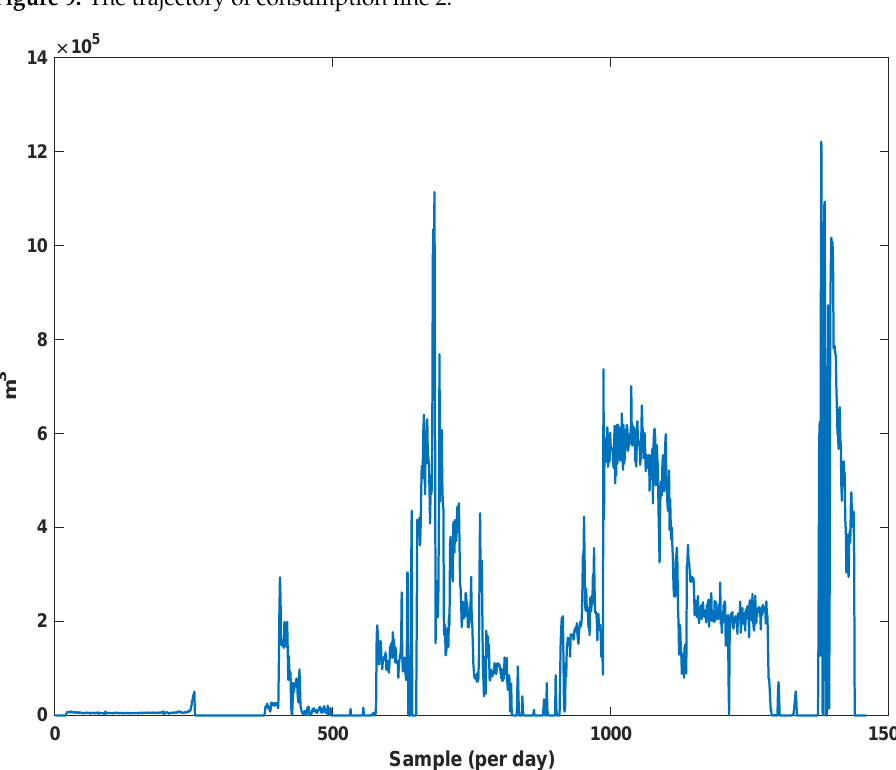
Figure 10. The trajectory of consumption line